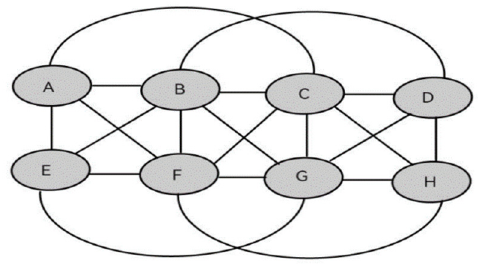
Figure 4. Cell cluster scheduling algorithm conflict graph.